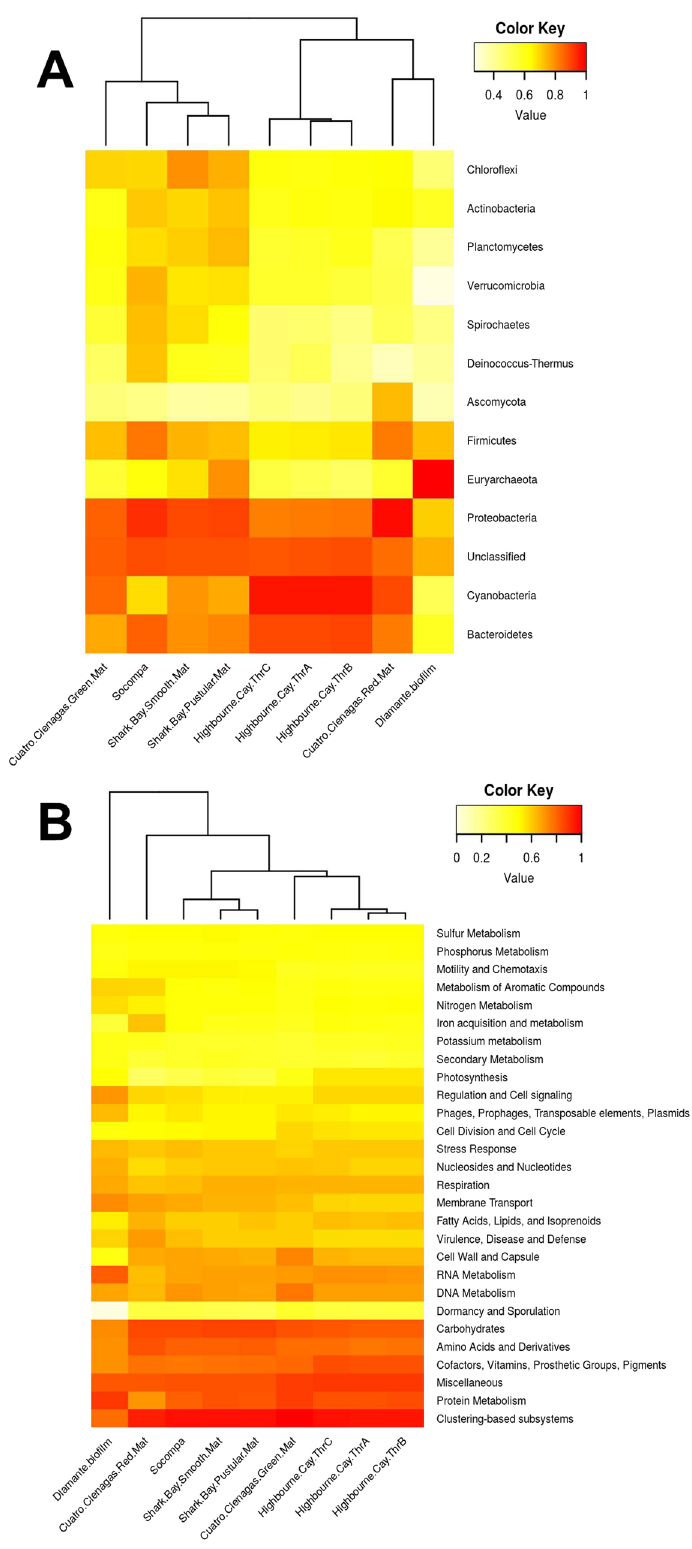
Figure 2. Comparative analysis of several microbial communities at taxonomic phylum level ( A ) and functional level ( B ). Abundance data normalized by MG-RAST is represented with a color gradient from white (less abundant) to red (most abundant). Comparisons were performed with R vegan package and heatmaps were generated with R gplot